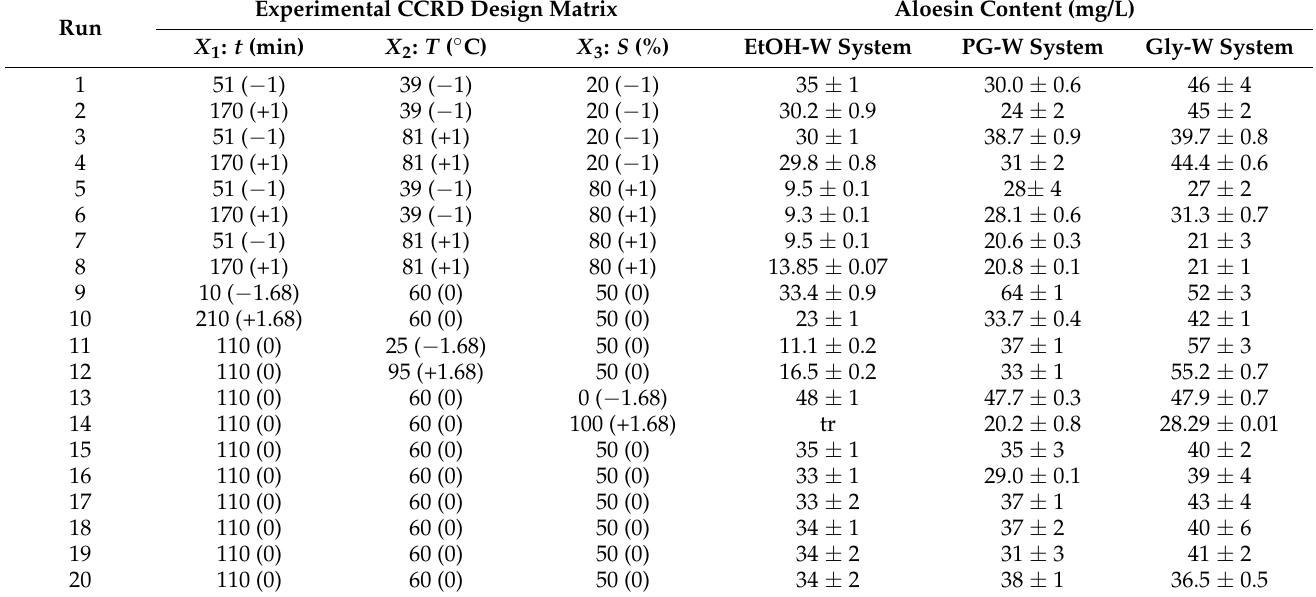
Table 1. Aloesin concentrations obtained experimentally under the extraction conditions defined by the CCRD design matrix as a function of the applied alcohol–water system. The levels of the independent variables are presented in the actual and coded (in brackets)